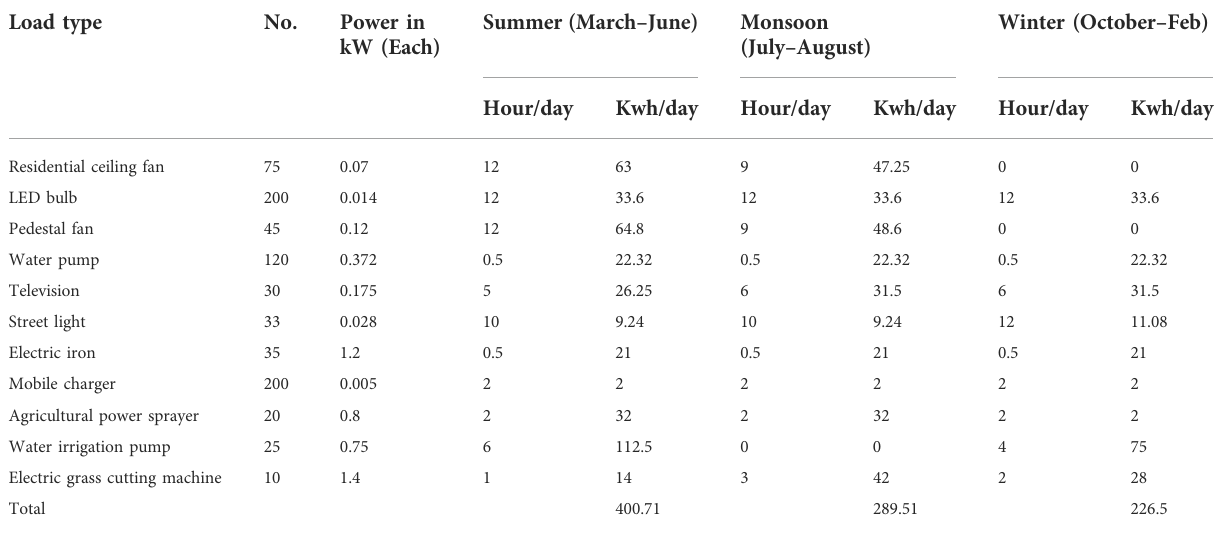
TABLE A1 Real-time village load